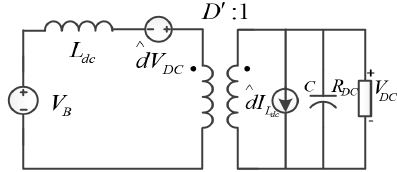
Figure 3. Small-signal equivalent model of DC/DC converter.